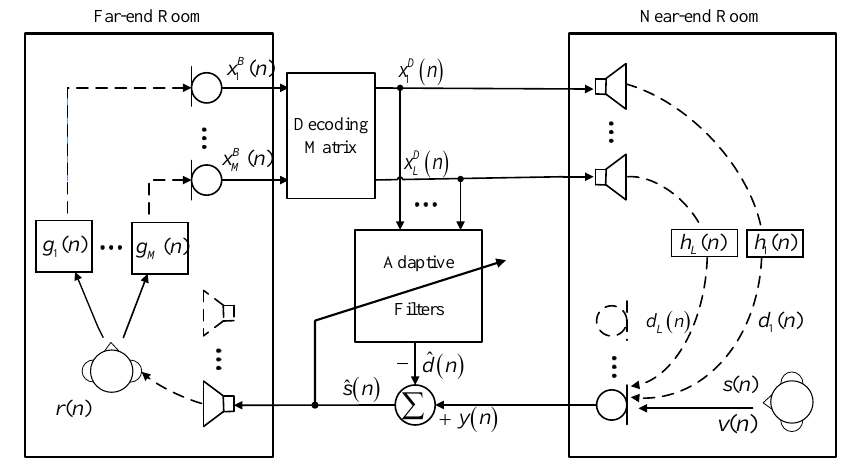
Figure 2. Diagram of a surround sound acoustic echo